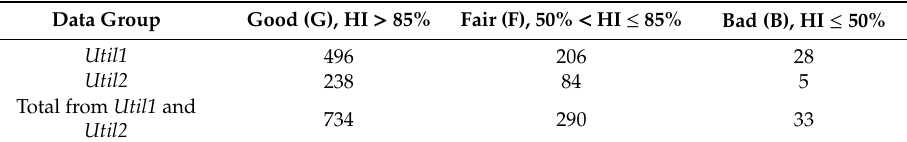
Table 1. Health index value range of health condition classes and the corresponding number of samples.